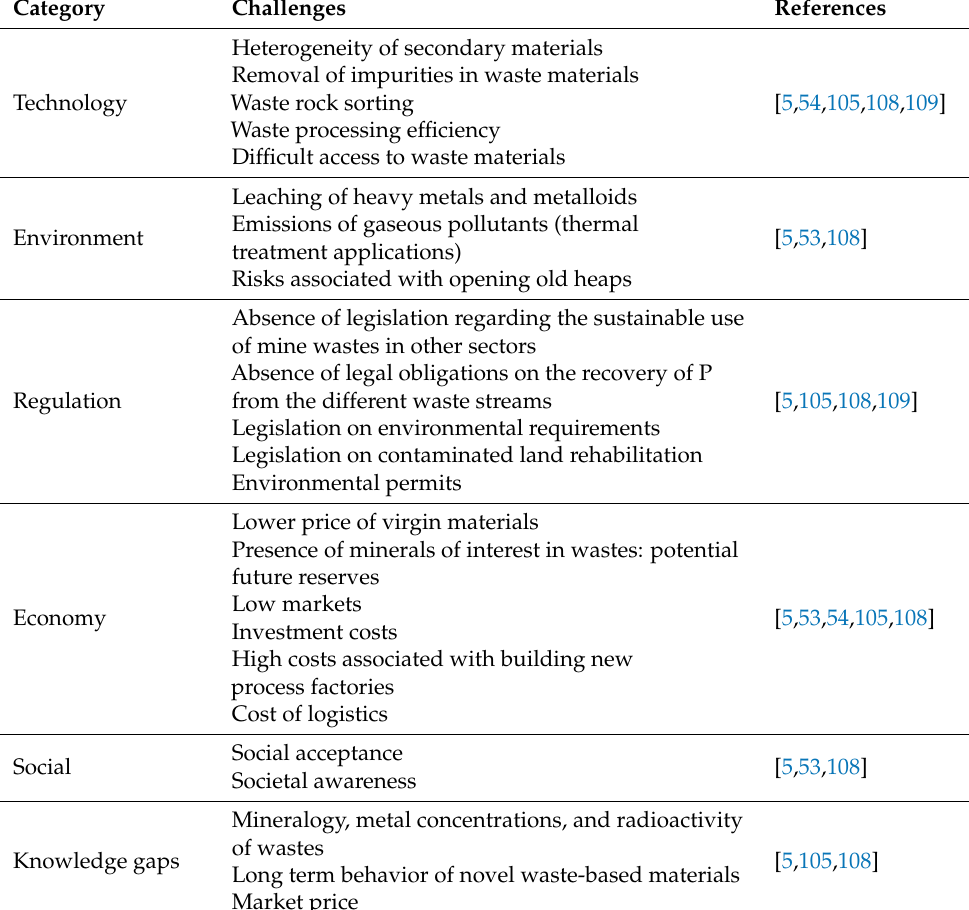
Table 2. Synthesis of the main challenges facing circularity in phosphate